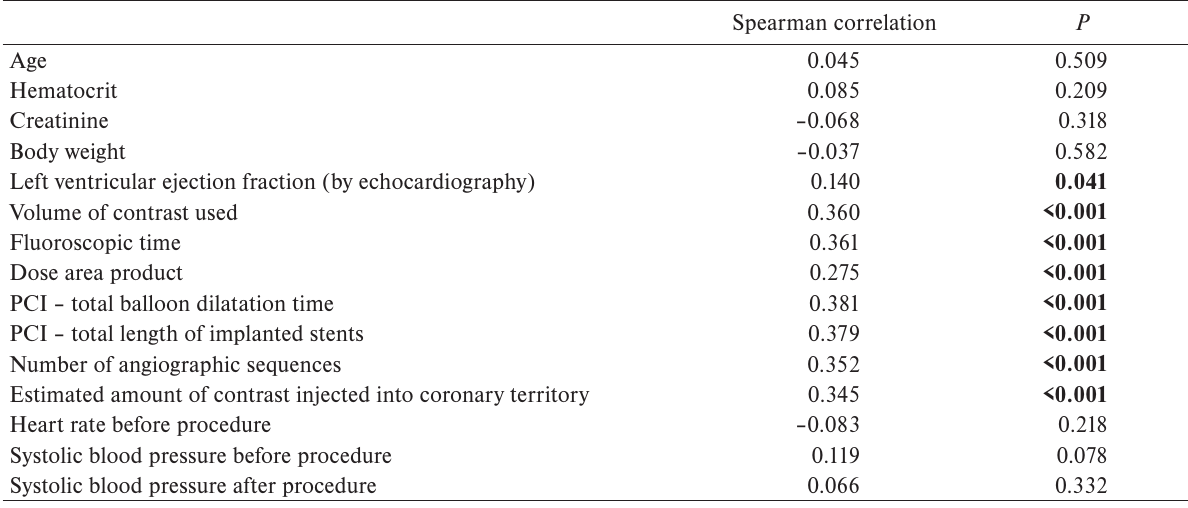
Table 5. Dependence of relative change in hs-cTnI on monitored variables (continuous